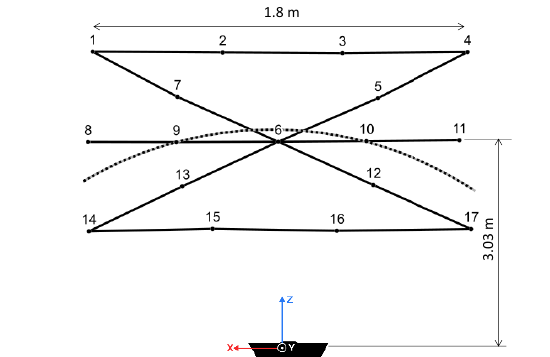
Figure 3. Designed trajectories illustration and the Kinect sensor corresponding position.